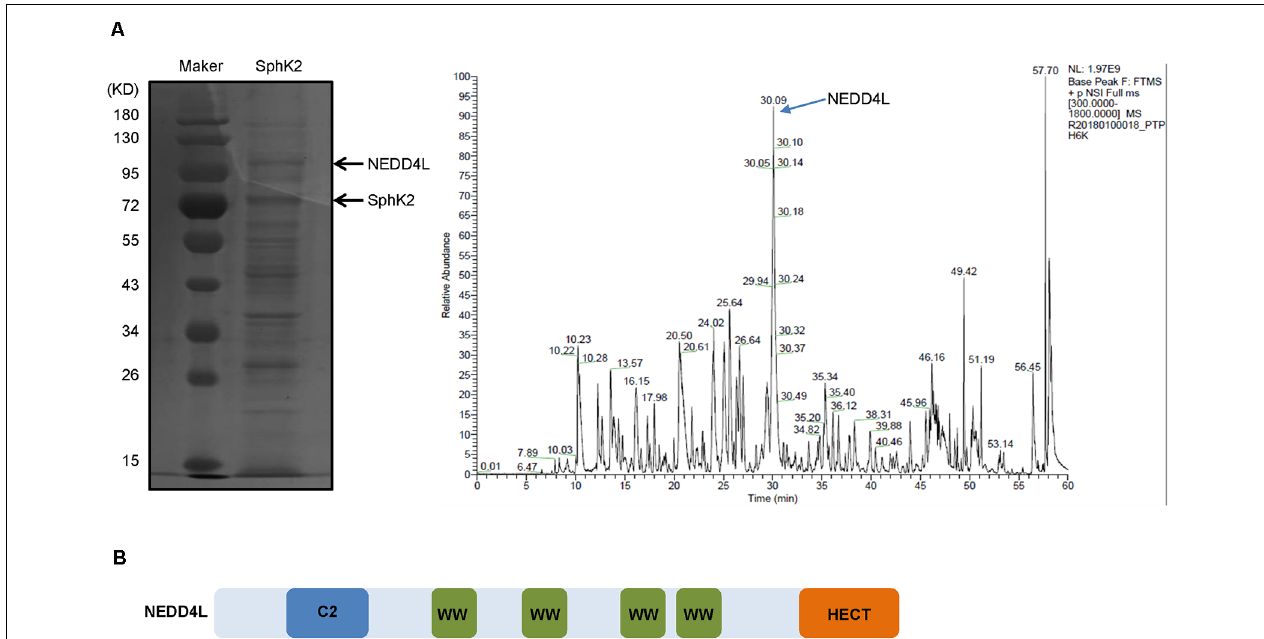
FIGURE 1 | Neural precursor cell-expressed developmentally downregulated 4-like (NEDD4L) gaining the highest interest among sphingosine kinase 2 (SphK2)-associated proteins. (A) Glioma U251 cells were transfected with SphK2 overexpression plasmid, and mass spectrometry assay was performed to analyze binding complexes formed with SphK2. The left side of panel (A) was a Western blot. The peak marked by the arrow in the right side of panel (A) represented NEDD4L. (B) Structure model of NEDD4L protein. The WW domain could specifically identify and bind to substrates containing PPXY